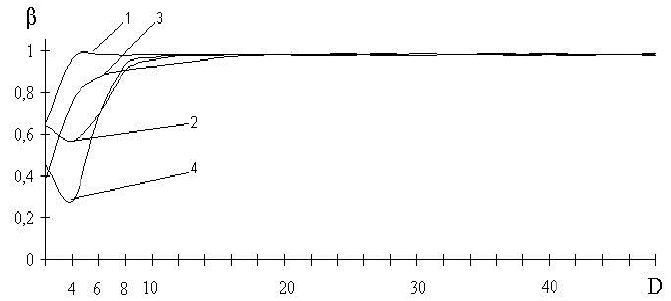
Fig. 13. Dependence ( ) f D  for various signal models.